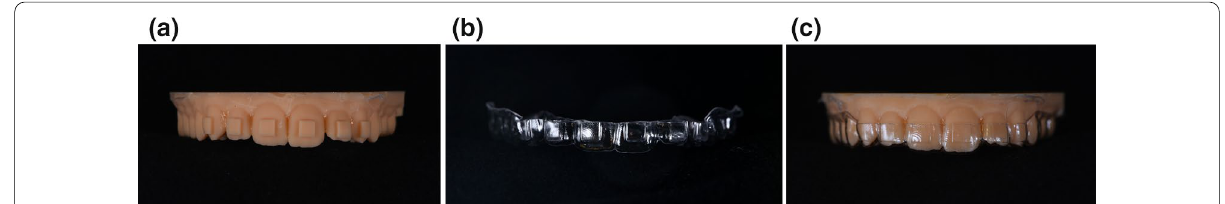
Fig. 1 a Upper arch model with same adhesive thickness; b resin template; c template positioning on the